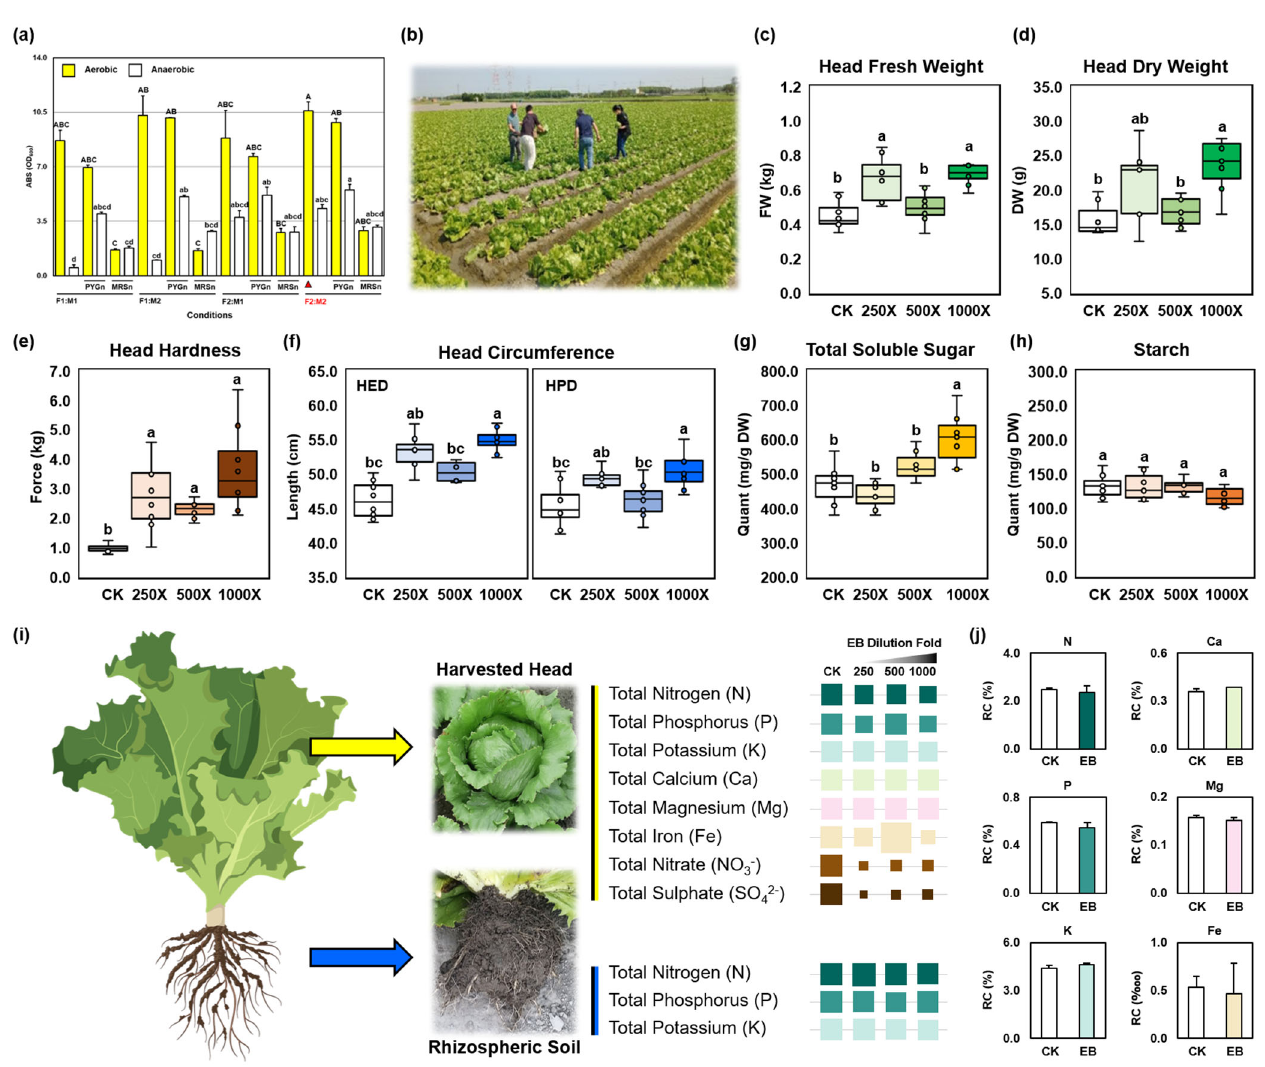
Figure 4. Endophytic biostimulants benefit lettuce grown in the field. ( a ) The best fermentation medium (BFM) testing conditions. PYGn and MRSn are two different nutrient supplements; F1,2 and M1,2 indicate different amounts of fish protein and molasses, respectively (see Materials and Methods (Section 2.4) and Tables S2 and S3 for details). The chosen BFM is highlighted in red and labelled by an arrow. n = 3–4. Data are shown as the mean ± SEM. ( b ) Image of in-field sample collection. Phenotypes of harvested heads: ( c ) fresh weight (FW), ( d ) dry weight, ( e ) hardness, ( f ) circumference length (HED, equatorial diameter; HPD, polar diameter), ( g ) total soluble sugar (TSS) and ( h ) starch content per sample dry weight (DW). 250×, 500× and 1000× indicate the endophytic biostimulant (EB) dilution values. n = 7–8. Data are presented in box and whisker plots. Different letters (i.e., “A, B, C” in ( a ) and “a, b, c” in ( a ) and ( c – h )) indicate statistically significant differences, p < 0.05. Lettuce inoculated with ( i ) BFM- and ( j ) LB-based cultivated EBs was used to perform nutrient element measurements, and the relative contents (RCs) are shown as coloured squares indicating the RC and data normalised relative to the CK (i.e., the square size of CK was fixed; a larger square presents a higher RC than that of the CK, and a smaller square presents the opposite) or shown as bar charts with the corresponding colours, mean ± SEM (see Tables S4 and S5 for details), * p < 0.05; otherwise, no signi fi cant. The le tt uce icon was created with BioRender.com.